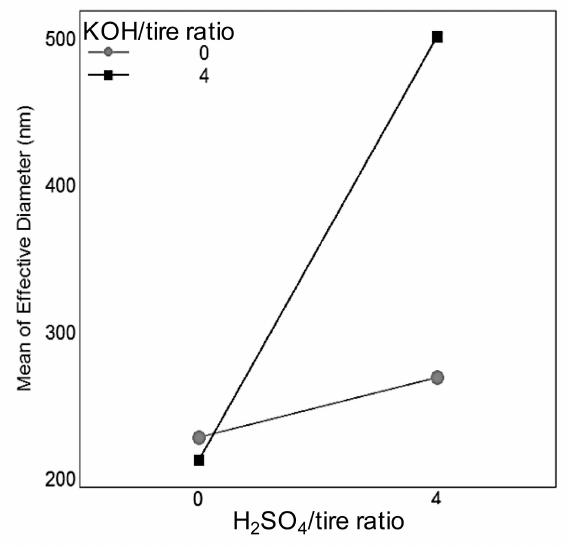
Figure 6. Interaction plot showing the KOH activation e ff ect increasing the e ff ective diameter when H 2 SO 4 activation is also